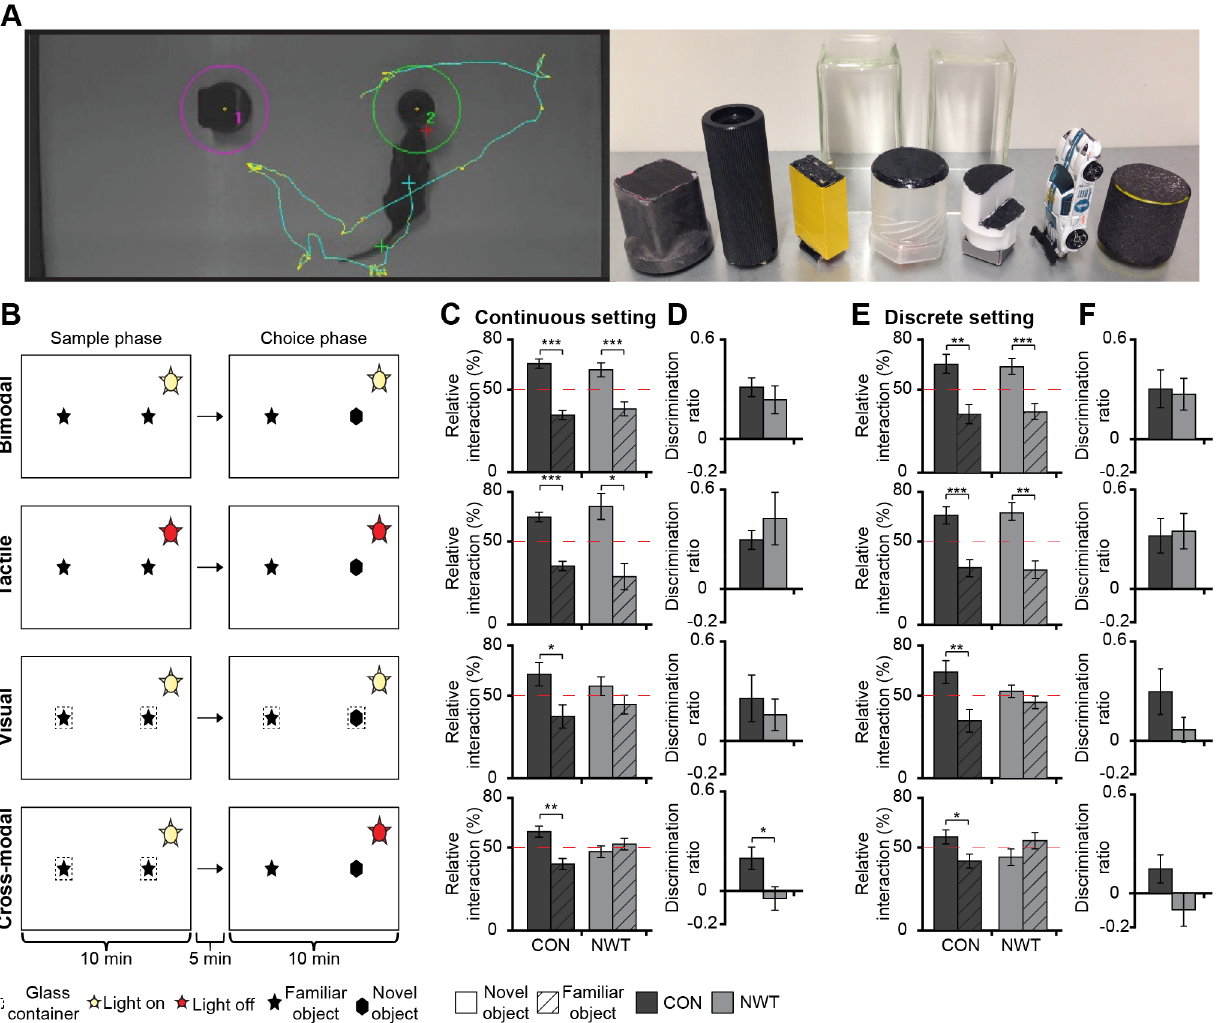
Fig 8. Impact of neonatal tactile restriction on the adult cross-modal matching performance. ( A ) Photograph displaying the tracking of a rat exploring two objects during NOR task (left) as well as the glass containers and objects with different shapes and textures that were used for the sample and choice phases of NOR (right). The red, cyan, and green crosses mark the head, center of gravity, and the tail of rat, respectively. ( B ) Illustration of the four experimental paradigms for testing novelty recognition and cross-modal matching. In the continuous setting each rat was consecutively tested in each experimental paradigm. In the discrete setting each rat was tested in a single paradigm (i.e., either bimodal, tactile, visual, cross-modal). ( C ) Bar diagrams displaying the relative interaction time spent by 15 CON (black) and 18 NWT (gray) rats with the new versus familiar object when investigated in the continuous setting during the experimental paradigms illustrated in (B). The red dotted line indicates chance level. ( D ) Bar diagrams displaying the discrimination ratios of new versus familiar objects during the experimental paradigm illustrated in (B) for CON (black) and NWT rats (gray) tested in the continuous setting. ( E ) Same as (C) for 36 CON and 33 NWT rats when investigated in the discrete setting ( n = 9 CON, 10 NWT in bimodal testing, n = 10 CON, 9 NWT in tactile testing, n = 8 CON, 6 NWT in visual testing and n = 9 CON, 8 NWT in cross-modal testing). ( F ) Bar diagrams displaying the discrimination ratios of new versus familiar objects during the experimental paradigm illustrated in (B) for CON (black) and NWT rats (gray) tested in the discrete setting. The underlying data of this figure can be found in S1 Data. http://dx.doi.org/10.6084/m9.figshare.1540797